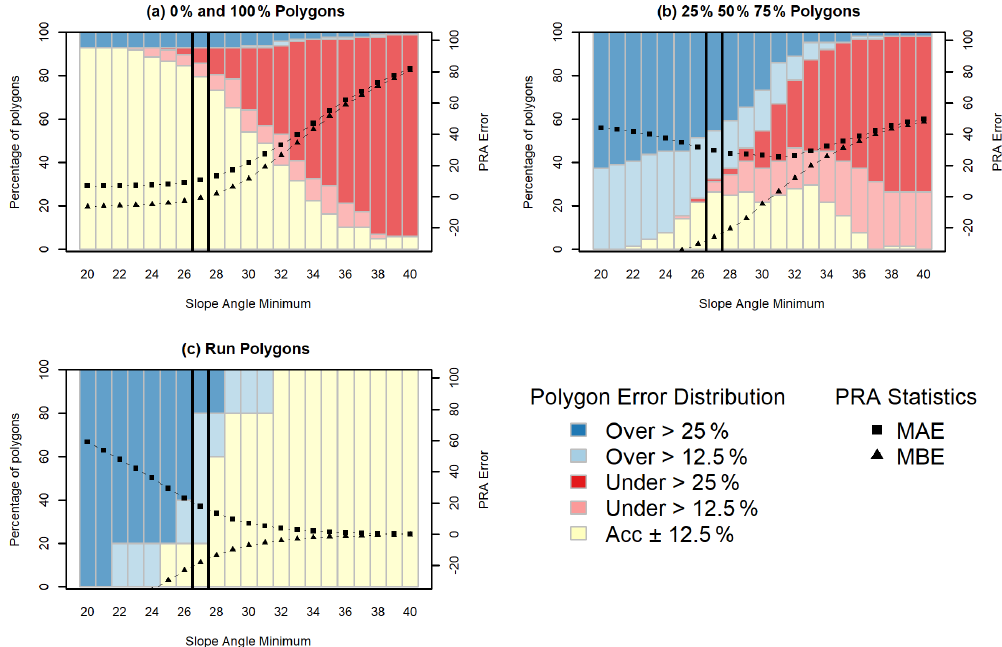
Figure 10. Frequent avalanche scenario PRA model grid search results for slope angle minimum with validation polygons split based on the type of polygon.